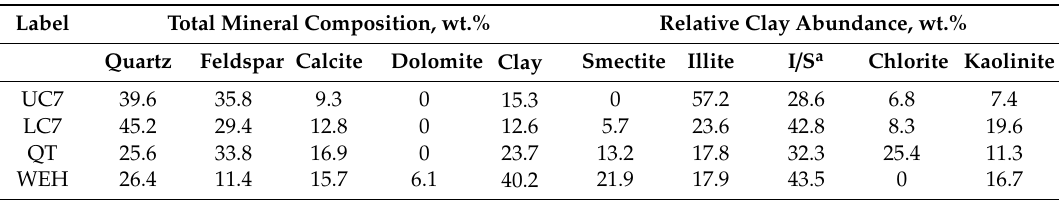
Table 2. The results of the mineral composition analysis.